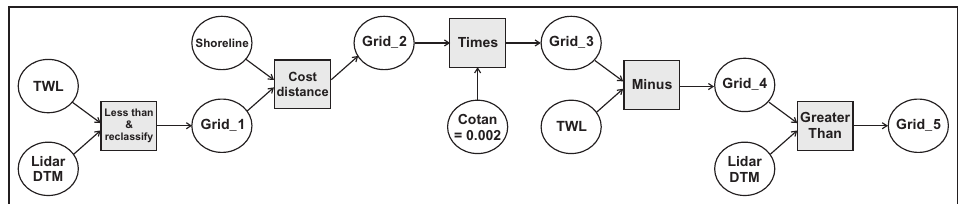
Figure 2. Flow diagram of the ArcGIS ® model: input and output are represented by ellipsoids; the ArcGIS ® tools (Less Than, Reclassify, Cost Distance, Times, Minus, Greater Than) are represented by rectangles.